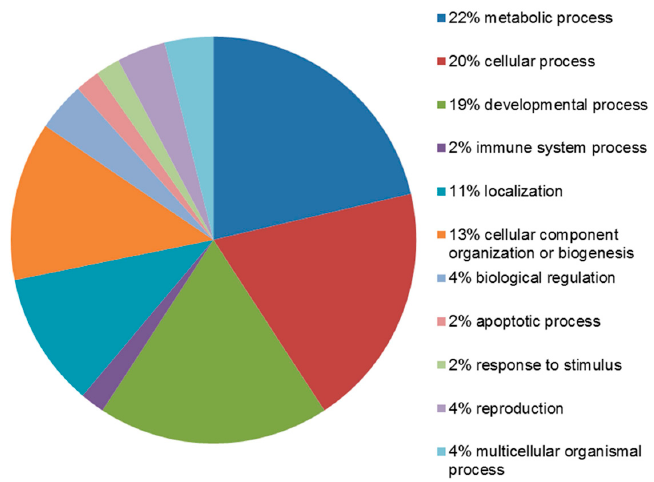
Figure 4. PANTHER classification of proteins upregulated in leiomyoma according to their biological process.